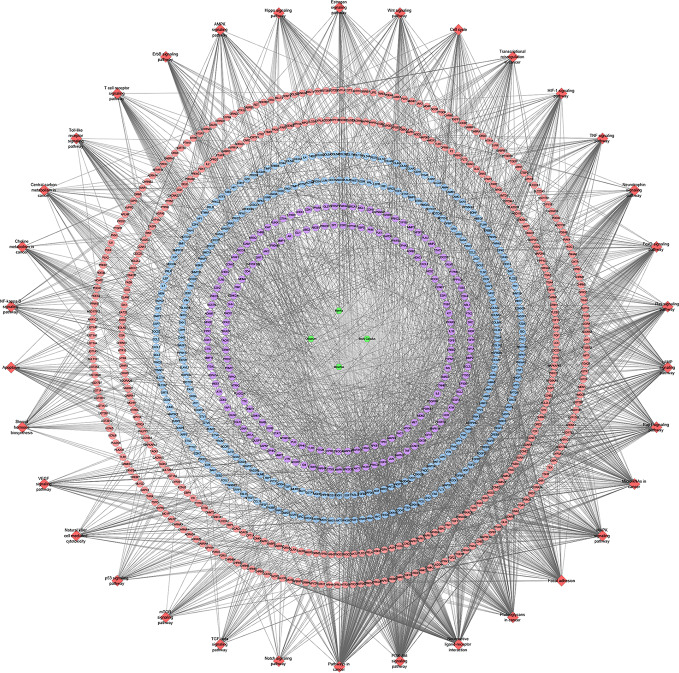
Signaling pathway of XHP-TNBC PPI network (Red diamond stands for signaling pathway; Purple circle stands for XHP-TNBC; Blue circle stands for TNBC genes; Pink circle stands for XHP targets).